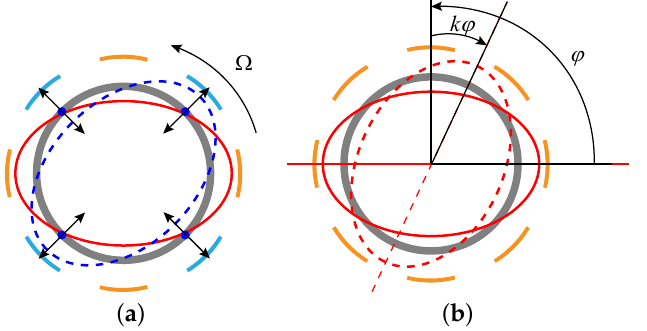
Figure 2. Two detection modes of ring gyroscopes ( n = 2): ( a ) Rate mode. ( b ) Rate integration